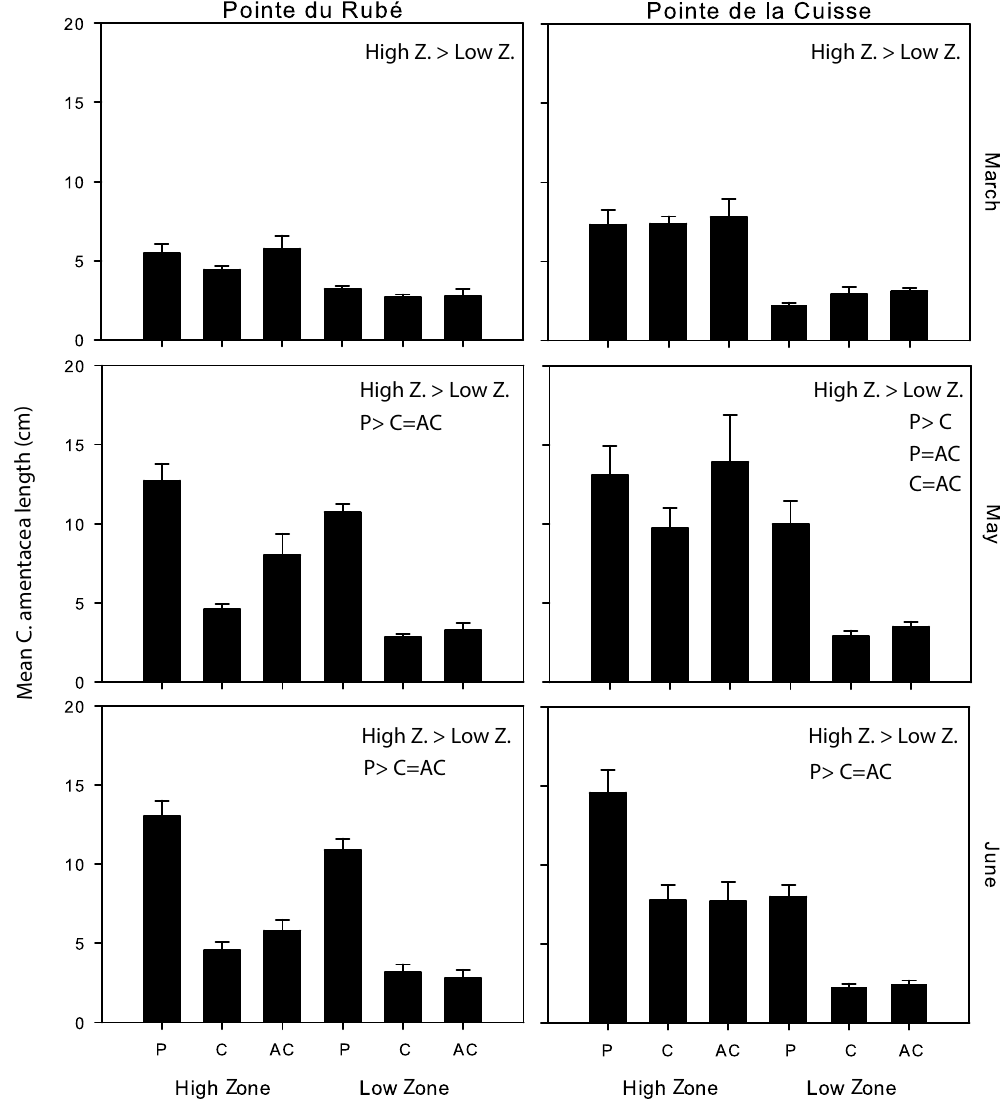
Figure 5. Algal size. Algal length (mean plus SE calculated on all plots, n = 4) for each zone (High and Low) and treatment in the different months and at both sites. P: protected; C: control plots; AC: artefact control. The results of the pairwise tests on the factors Treatment and Zone are reported above the graph (see Table 1 and Supplementary Tables S2.1–2 for more details).